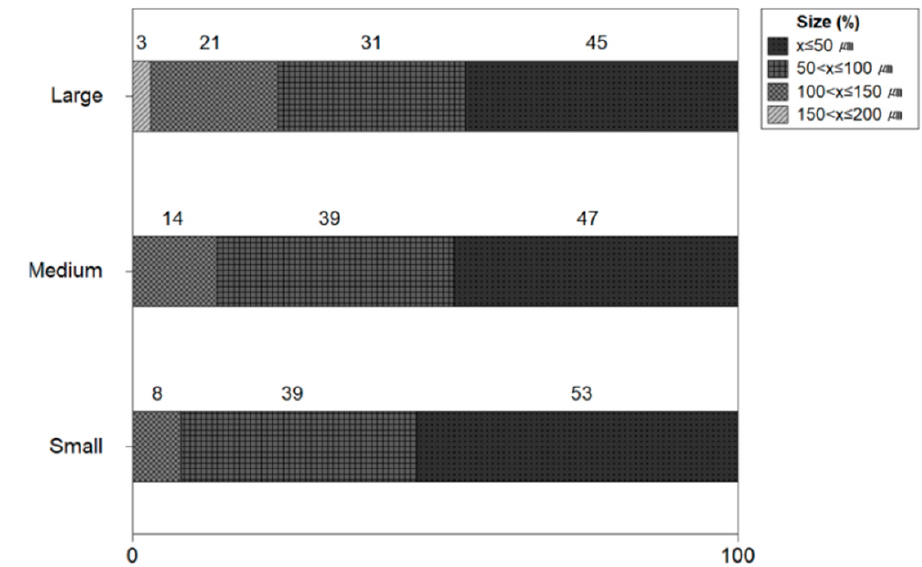
Figure 7. Size of microplastics by size of shrimp. Figure 8 expresses the color of microplastics by the size of the shrimp. The micro- plastic color of small-size shrimp resulted in the order of blue 61%, white 18%, black 6%, red 6%, green 2%, yellow 4%, and gray 2%. The microplastic color in medium size shrimp was reported in order of blue 63%, white 14%, red 7%, green 4%, yellow 2%, and gray 2%. The color of microplastics in large-size shrimp was confirmed to be blue 44%, white 18%, red 14%, green 11%, black 10% and yellow 4%. In all three sizes of shrimp, blue was iden- tified with the highest ratio.